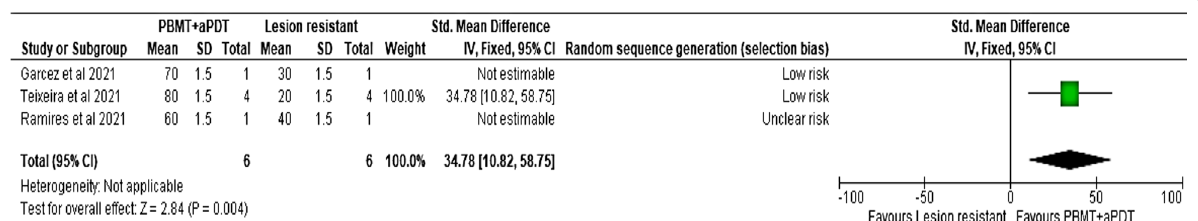
Fig. 2 Forest plot demonstrating meta-analysis for oral manifestations for COVID-19 patients facing the treatment of PBMT associated with aPDT